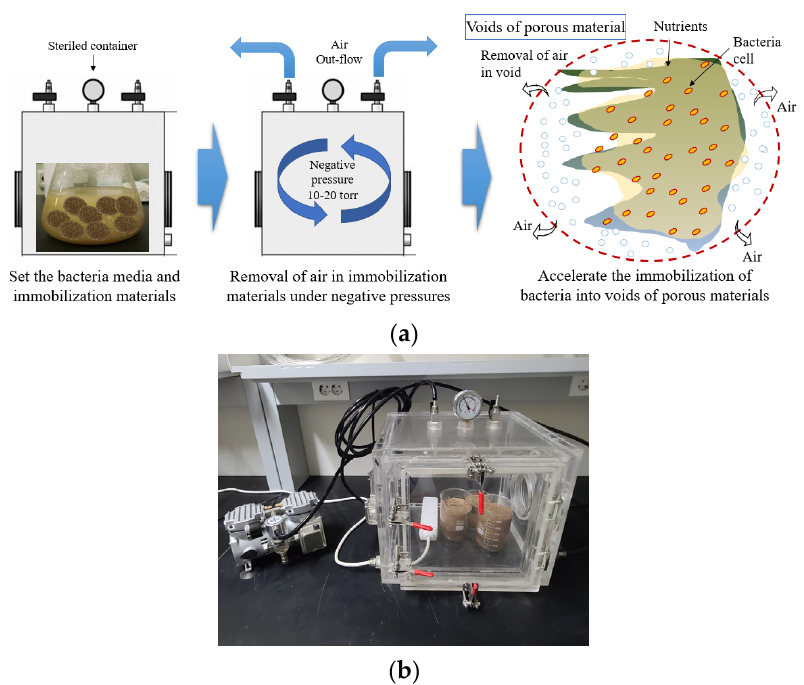
Figure 3. Negative pressure technique with the bacteria immobilization mechanism: ( a ) schematic diagram of the negative pressure device for improved bacteria immobilization; ( b ) photos for the negative pressure device.